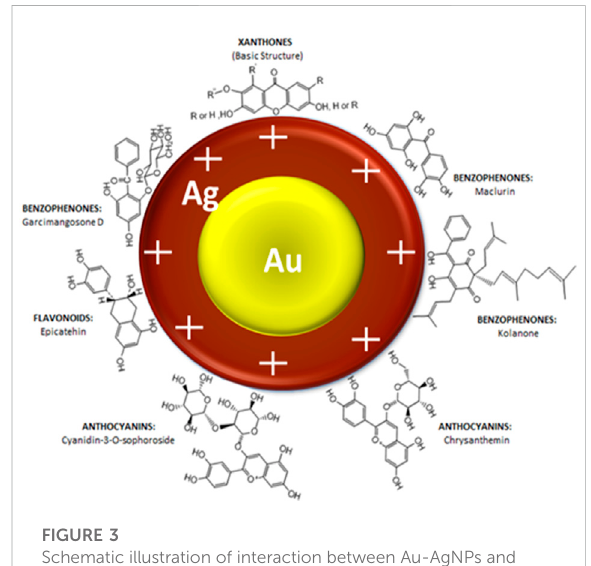
FIGURE 3 Schematic illustration of interaction between Au-AgNPs and the active functional groups present in GM peels